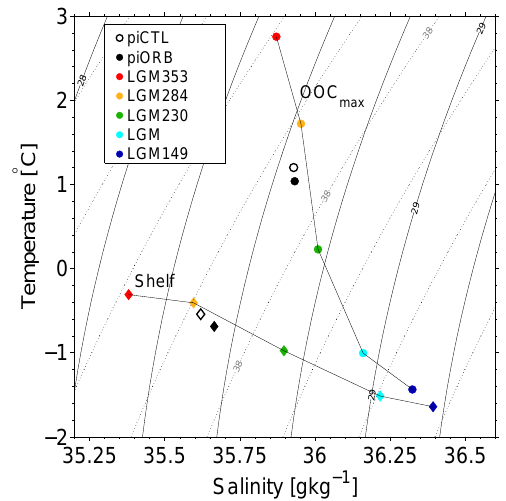
Figure 12. Annual mean temperature and salinity at 500m aver- aged over the Weddell Sea shelf region (diamonds) and the OOC max region (circles). Solid contours indicate σ (cid:50) , and dotted contours in- dicate σ 2 . The contour interval is 0.2kgm − 3 . For an easier compar- ison with the glacial setup runs, the salinity of piCTL and piORB has been offset by 1.21gkg − 1 to account for the global mean salin- ity difference caused by the lower glacial sea